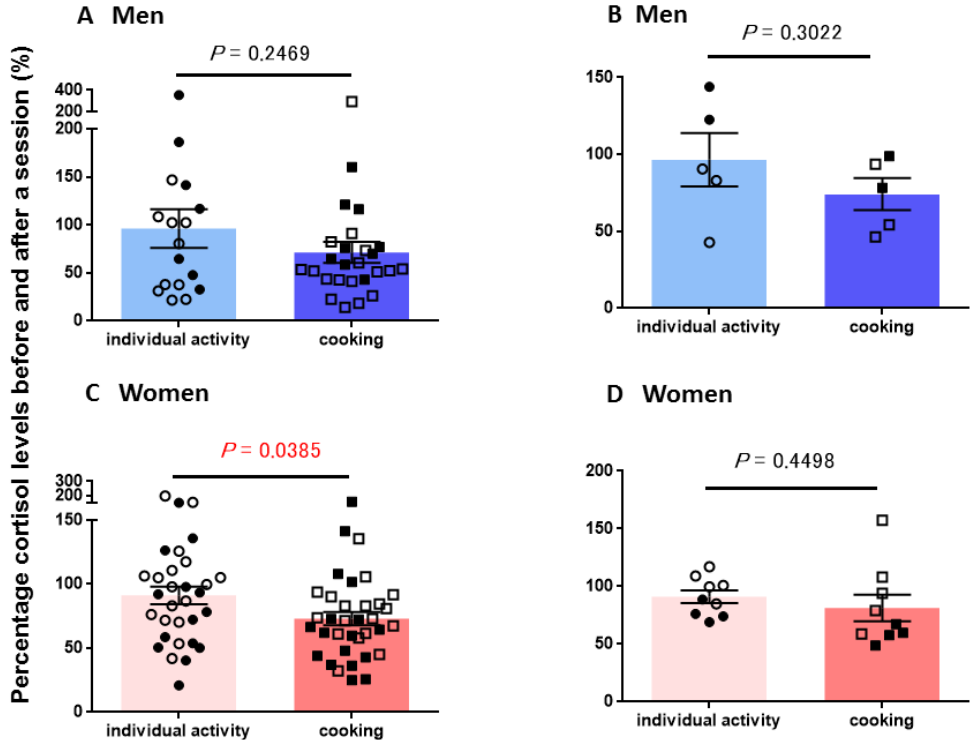
Figure 4. Changes in cortisol levels before and after a single session. Percentage of CORT levels for the first (before) saliva over the second (after) saliva samples after each session. Saliva was collected at individual (non-cooking) and group (cooking) activities in men ( A , B ) and women ( C , D ). Average percentage of cortisol levels for the first (before) saliva over the second (after) saliva samples in individual participants. p -values are for two-tailed Student’s t -tests: ( A ) p = 0.2469 between individual activity (n = 17) and cooking (n = 26) in men; ( B ) p = 0.3022 between individual activity and cooking in 5 men; ( C ) p = 0.0385 between individual activity (n = 31) and cooking (n = 35) in women; ( D ) p = 0.4498 between individual activity and cooking in 9 women. Filled and open symbols represent married and single participants, respectively.